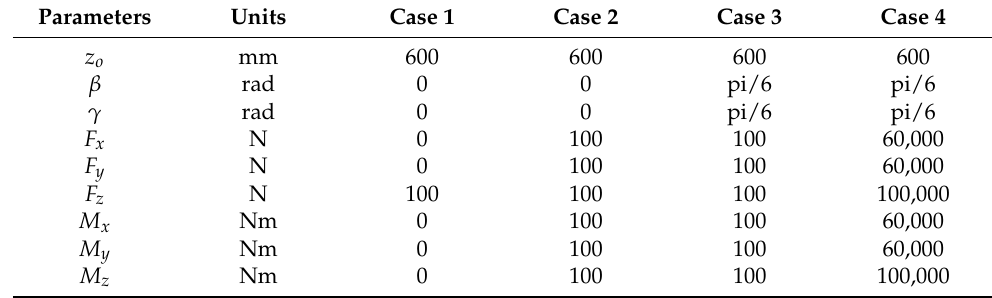
Table 2. Four selected cases of the redundantly actuated 2UPR – 2PRU PM.